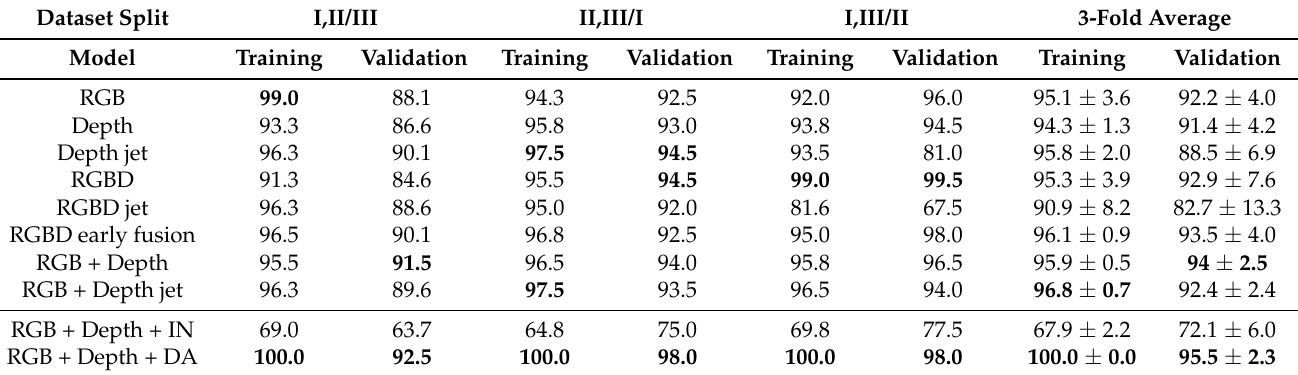
Table 1. The accuracy [%] of the considered models in the task of wiring harness classification for the 3-fold cross-validation. Dataset